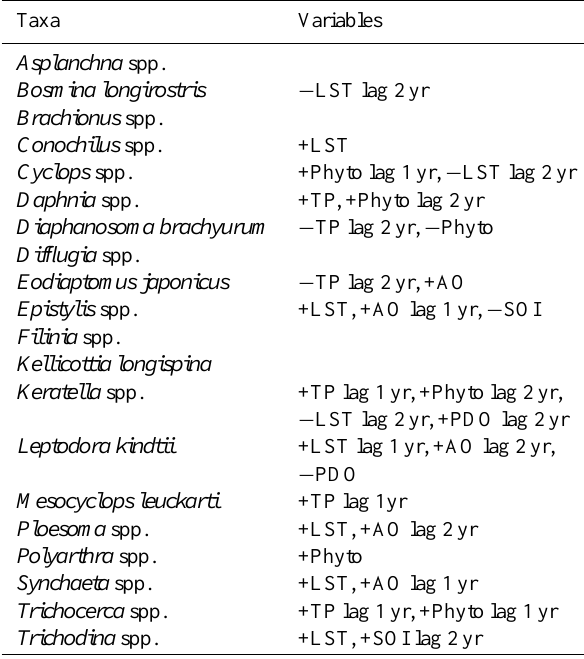
Table 1. Results of the correlation analyses between zooplankton abundance and environmental